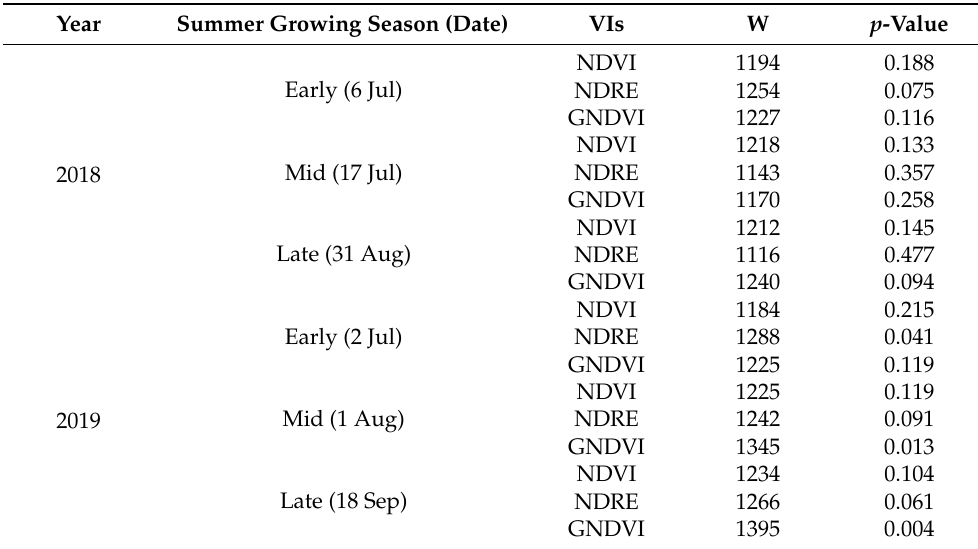
Table 6. Mann–Whitney–Wilcoxon results showing significant differences of VIs collected over three flights between four nitrogen treatments during the early-, mid-, and late-summer growing season in 2018 and 2019.